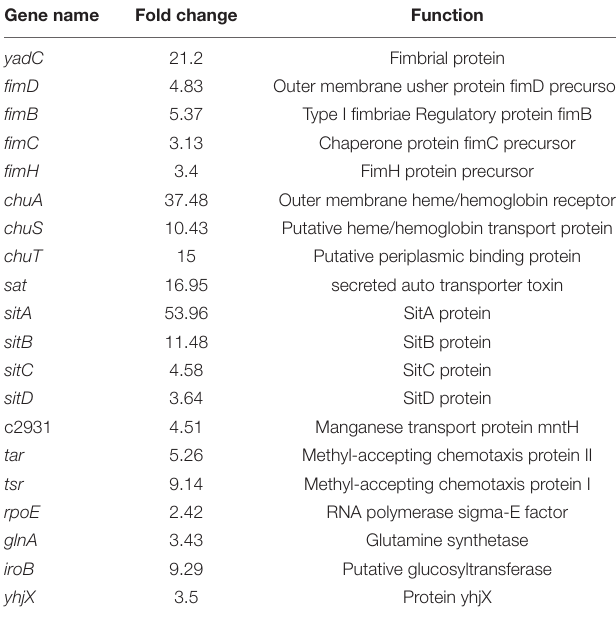
TABLE 1 | Genes positively regulated 8 h